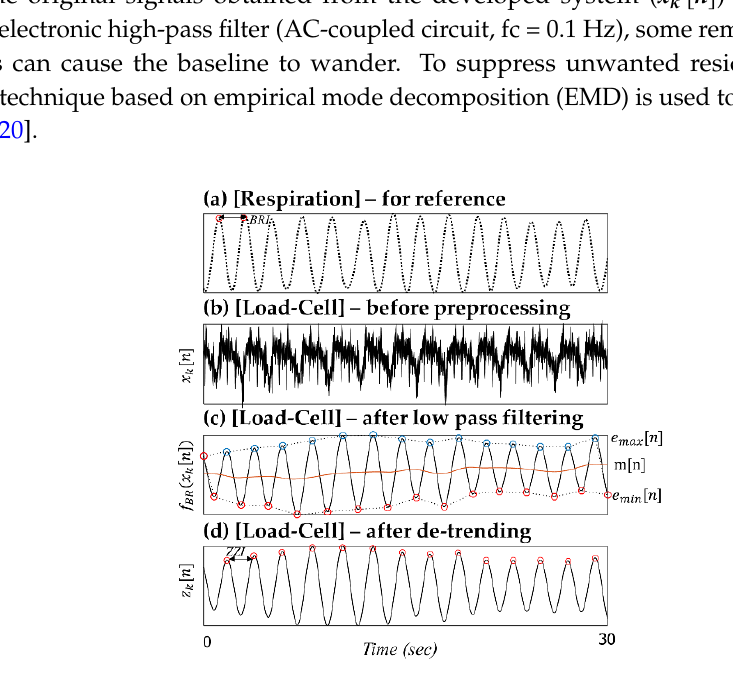
Figure 7. Signal quality check based on the THV-S and sensor selection for HR analysis.